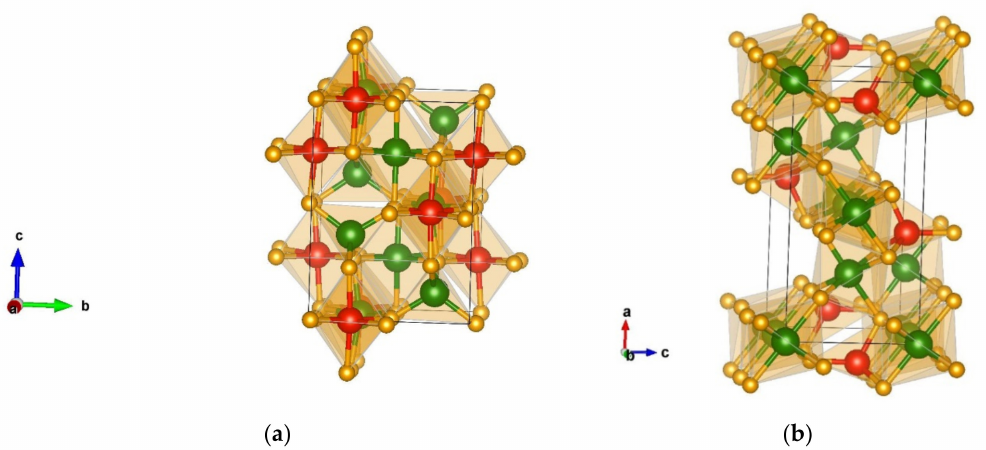
Figure 6. Visualization of favorable Cr2SiN4 modifications: ( a ) TiMn2O4-type in space group P4322 (no. 95); ( b ) Mg2SiO4- type in space group Pnma (no.62). Green, red, and yellow spheres denote Cr, Si, and N atoms,